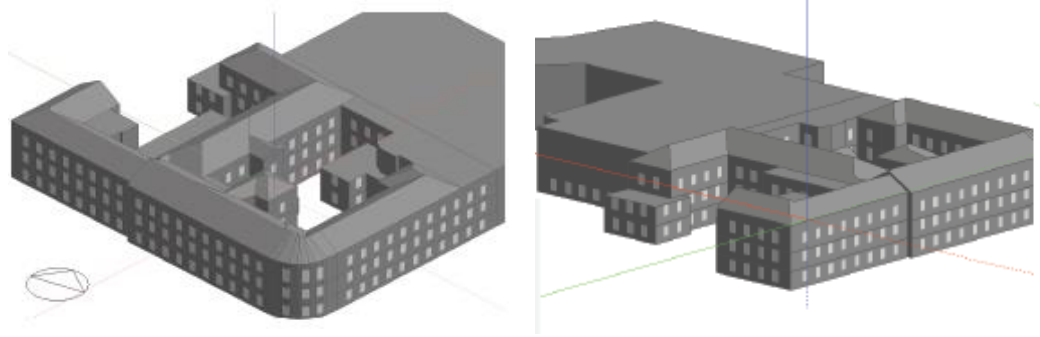
Figure 12. Design Builder model of the building current state. Table 1. Input data of the DesignBuilder model for the simulation.